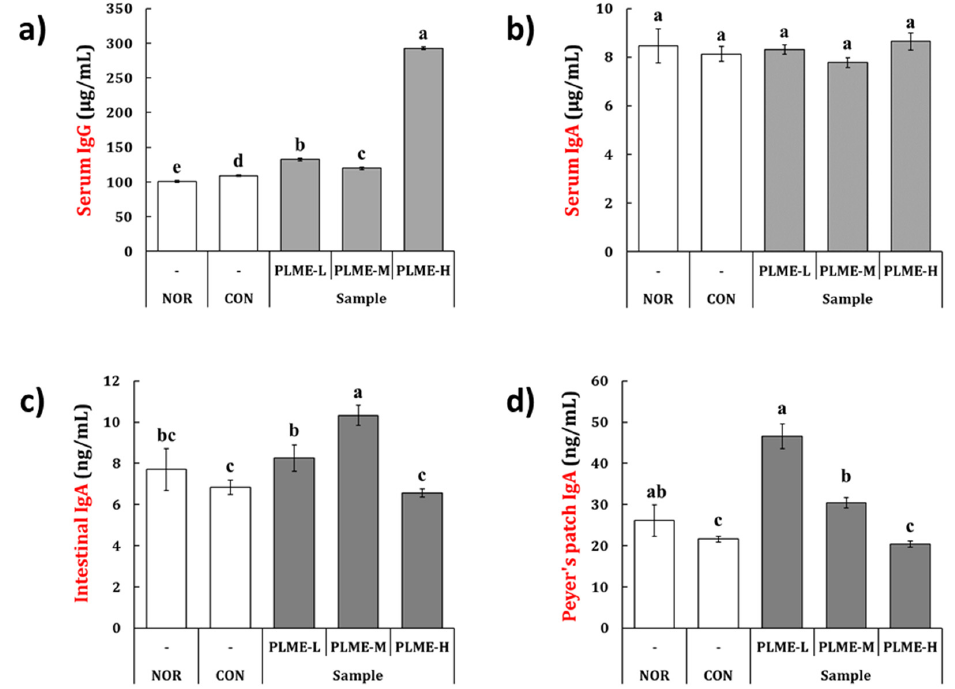
Figure 4. The effect of PLME administration on the level of ( a ) serum IgG, ( b ) serum IgA, ( c ) IgA in the small intestinal fluid, and ( d ) IgA in the Peyer’s patch. Each immunoglobulin was determined using ELISA. Different letters indicate a significant difference among groups ( p < 0.05) using Tukey’s multiple range test. NOR, normal group administered tap water; CON, medium control group ad- ministered only culture medium (250 mg/kg/day); PLME-L, PLME-M, and PLME-H, sample groups administered postbiotics prepared from P. linteus mycelial submerged culture at doses of 250, 500, and 1000 mg/kg/day, respectively. 2.4. Effect of PLME Administration on the Intestinal Immune System-Modulating Activity through Peyer’s Patch To evaluate the effect of PLME administration on the intestinal immune system, bone marrow cell proliferation was measured by inoculating conditioned medium with Peyer’s patch cells isolated from each group of mice. Following 6 days of incubation with the con- ditioned medium, morphological changes and proliferation activity of bone marrow cells were measured. Representative images of bone marrow cells and the quantified results are depicted in Figure 5a,b, respectively.